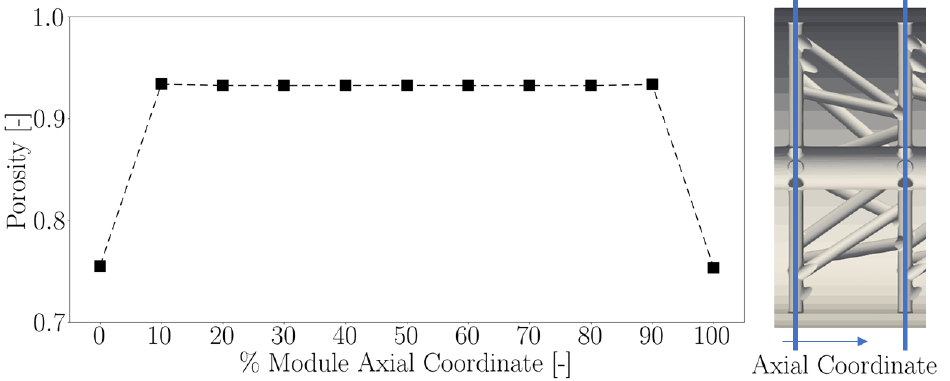
Figure 3. POCS geometrical characterization: Porosity trend with respect to the module axial